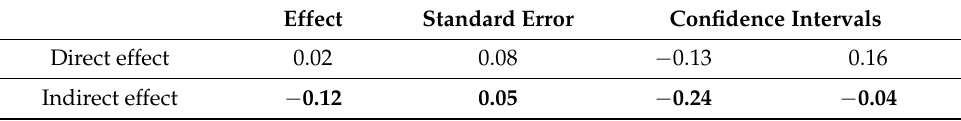
Table 4. Direct and indirect effects of perceived religious discrimination on perceived stress.